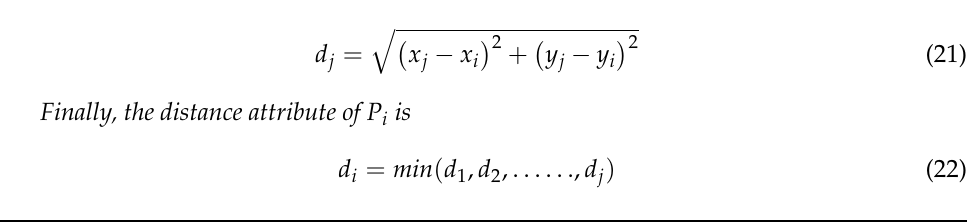
Algorithm 2. MNNC for the path tracking of magnetic